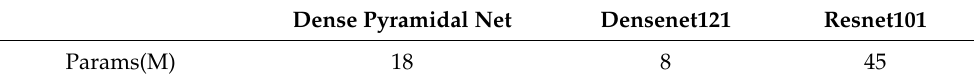
Table 3. Three model